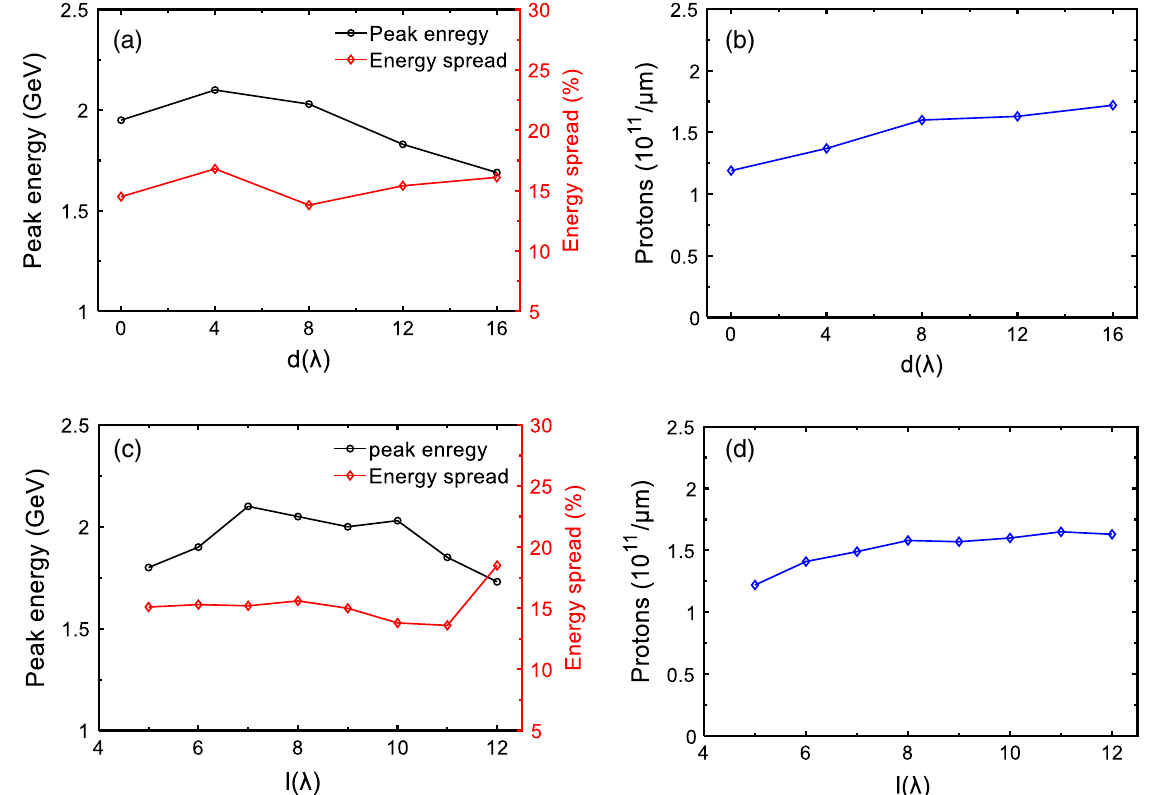
FIG. 8. Scaling of the peak energy, energy spread, and the number of protons against the plasma channel locations ( d ) and wall widths ( l ) at t ¼ 300 fs. The simulations for scan are performed with the other parameters unchanged. Here, we choose the protons in the region of − 6 λ ≤ y ≤ 6 λ